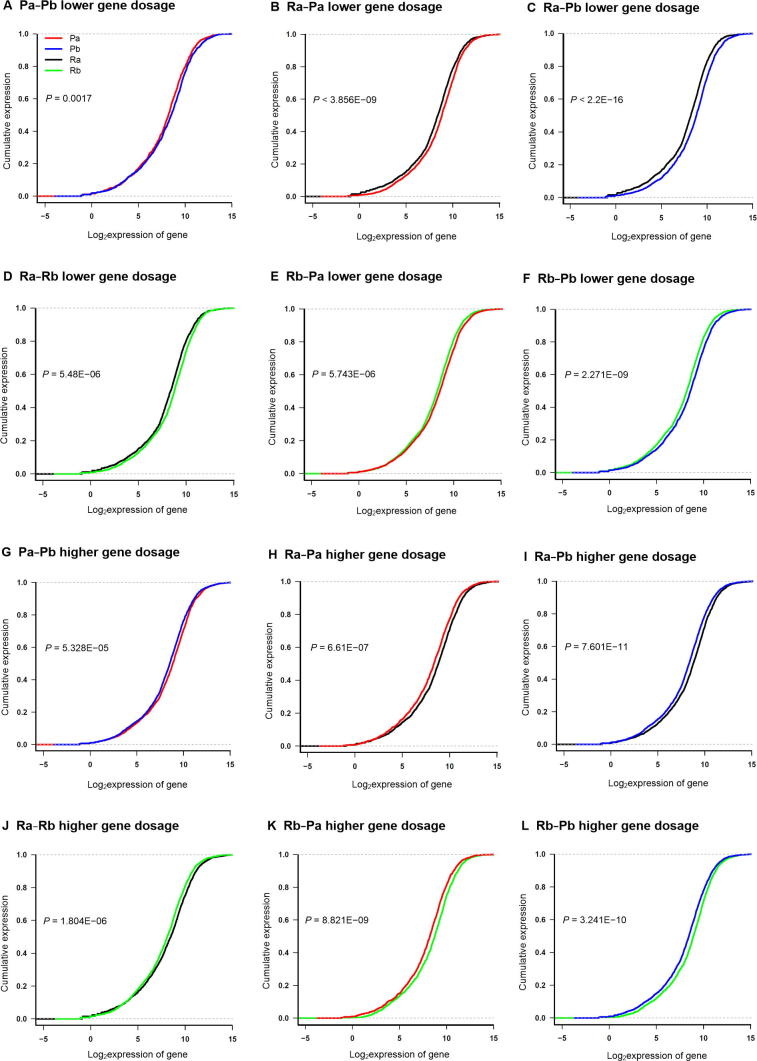
Cumulative distribution of gene expression for genes in regions with CNAs between any two samples The X-axis denotes the gene expression level (read counts) on the log2 scale, and the Y-axis denotes the cumulative proportion of gene expression. The P values were derived from the one-sided Kolmogorov−Smirnov test. Genes showing absolute copy number differentiation between the compared samples were used to plot the cumulative distributions. A.−F. Cumulative distribution of the expression of genes located in regions of copy number loss for pair-wise comparisons, Pa vs. Pb, Ra vs. Pa, Ra vs. Pb, Ra vs. Rb, Rb vs. Pa, and Rb vs. Pb. G.−L. Cumulative distribution of the expression of genes located in regions of copy number gains for pair-wise comparisons, Pa vs. Pb, Ra vs. Pa, Ra vs. Pb, Ra vs. Rb, Rb vs. Pa, and Rb vs. Pb.